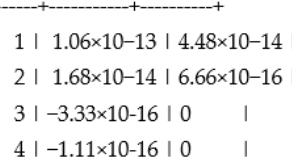
Scheme 7. Testing the exact intersection with the new function.